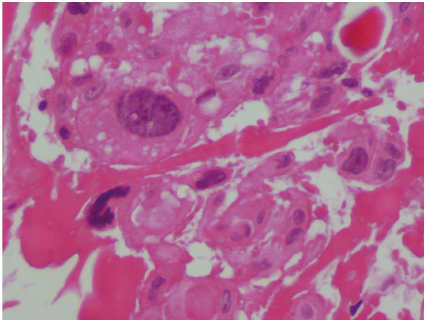
Figure 4: Photomicrographs of the tumor specimen showing nuclear atypia with prominent nucleoli. Hematoxylin and eosin; magnification: ×